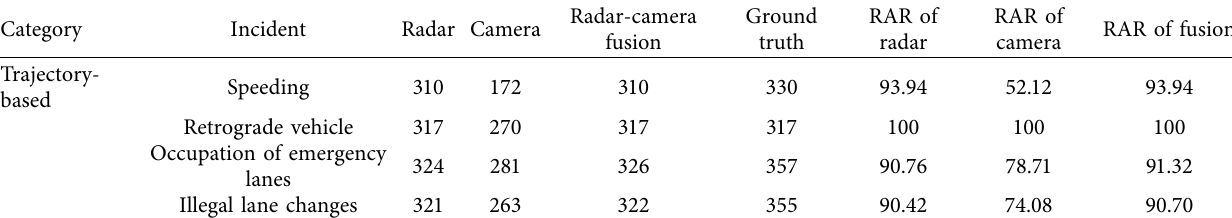
Table 5: Incident detection results in night long road